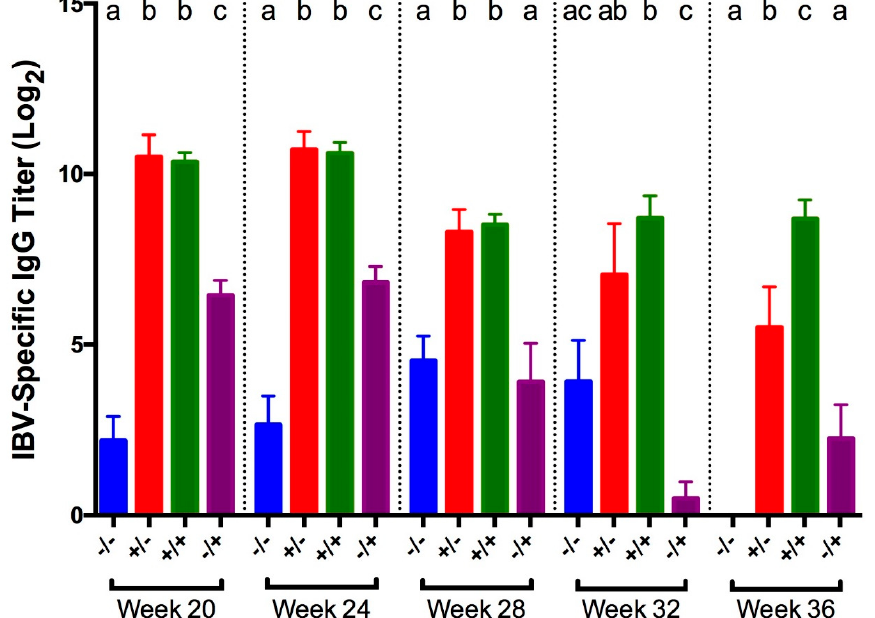
Figure 2. IBV-specific IgG titers in serum collected 5 days post-challenge with IBV GA98 for different groups of birds challenged at 20, 24, 28, 32, and 36 WOA. Letters (a–c) indicate significant differences among vaccine and challenge groups for each week ( p < 0.05). − / − = non-vaccinated/non-challenged, +/ − = vaccinated/non-challenged, +/+ = vaccinated/challenged, − /+ = non-vaccinated/challenged. Viruses 2019 , 11 , x FOR PEER REVIEW IBV-specific IgA titers were measured in tears collected at 5 dpc at 28, 32, and 36 WOA. At 28 WOA, titers in vaccinated/challenged birds were significantly higher compared to titers in non- challenged negative controls (Figure 3). At 32 WOA, vaccinated/challenged birds showed significantly lower titers compared to positive controls. In addition, the vaccinated/challenged birds had significantly higher titers than the vaccinated/unchallenged group at 28 WOA. No other significant differences were detected.